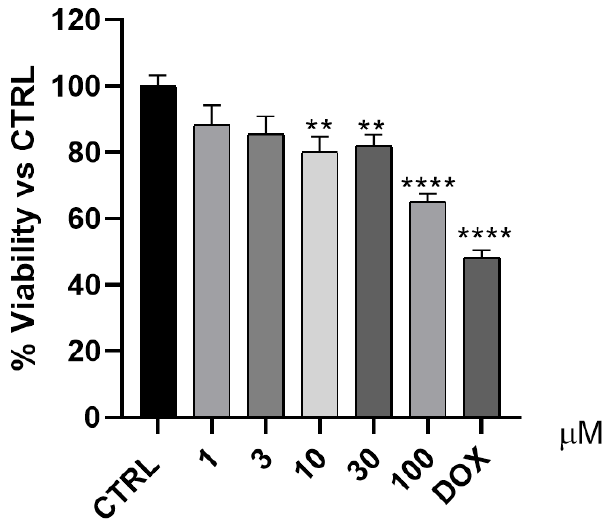
Figure 14. The antiproliferative effect of 3 was evaluated against the A549 cell line. ** p < 0.01 and **** p < 0.0001 indicates indicates statistically significant difference from the corre-sponding control (unteated A549 cells).